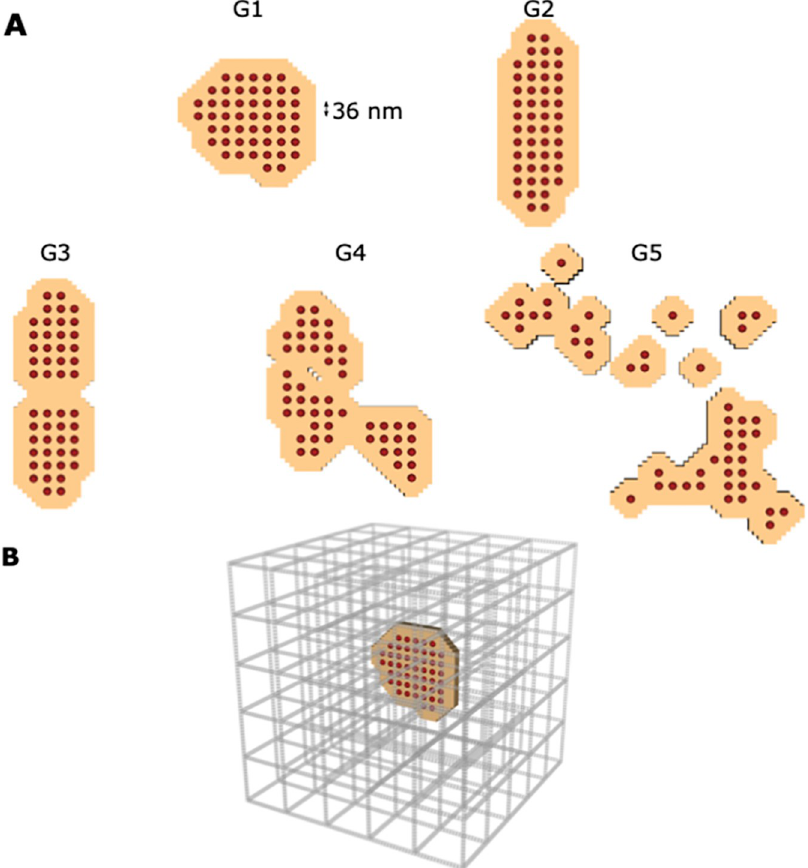
Fig 2. Cluster geometries and cytosolic domain. (A) The five different RyR geometries studied in the model. The red dots show the single RyRs and the tan coloured area represents the junctional SR membrane. All five geometries contain 50 RyRs. The first two geometries (G1 and G2) contain a single cluster to simulate the healthy case. The latter 3 geometries (G3, G4, and G5) differ in the number of CRU sub-clusters, to simulate the disrupted RyR clusters observed during HF. G3, G4 and G5 are organized into 2, 3 and 12 sub-clusters respectively. (B) The computational domain of the cytosol is presented. The space corresponds 1.008 μ m x 1.008 μ m x 1.008 μ m. The grey bars represent the non-junctional